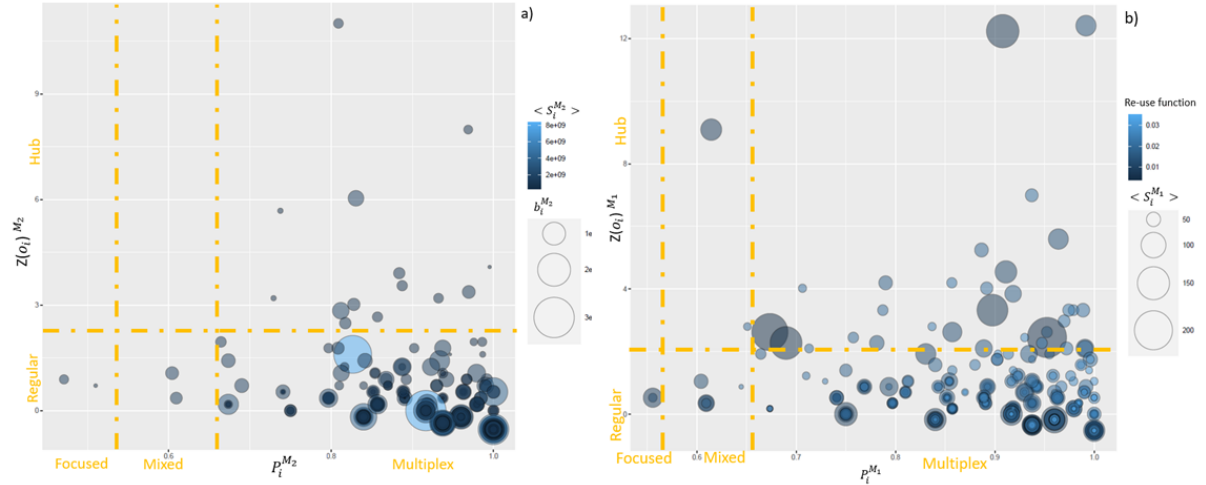
Figure 5. Role of nodes: ( a ) multiplex participation coefficient ( P i ) M 2 versus the Z-score ( z ( o i )) M 2 ), for each node in M 2 (color indicates the average strength (cid:104) s i (cid:105) M 2 and the size of nodes represents the measure of complex involvement ( b i ) M 2 ); ( b ) multiplex participation coefficient ( P i ) M 1 versus Z-score for each node in M 1 (color indicates the Reuse function of resources in M 1 and the size of nodes represents the average strength (cid:104) s i (cid:105) M 1